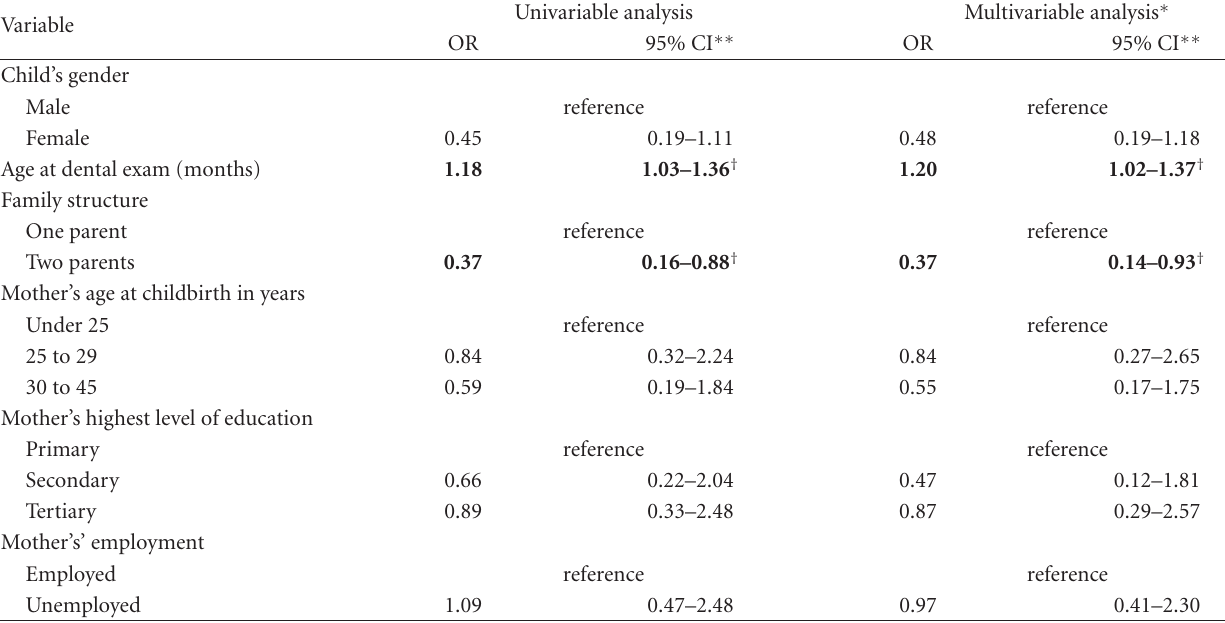
Table 5: E ff ect of various factors on the prevalence of severe early childhood caries at 20 ± 2.5 months of age in univariable and multivariable logistic regression analyses ∗